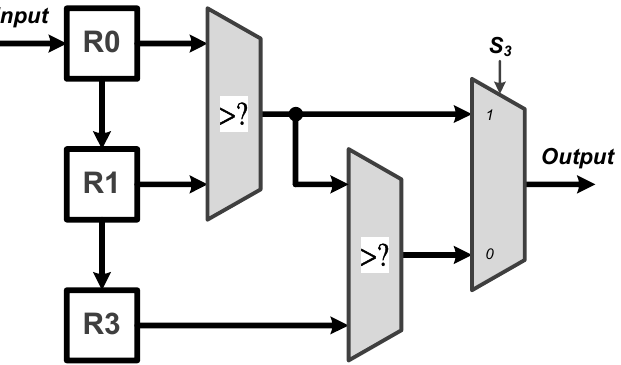
Figure 5. Architecture of the proposed MaxPooling module.